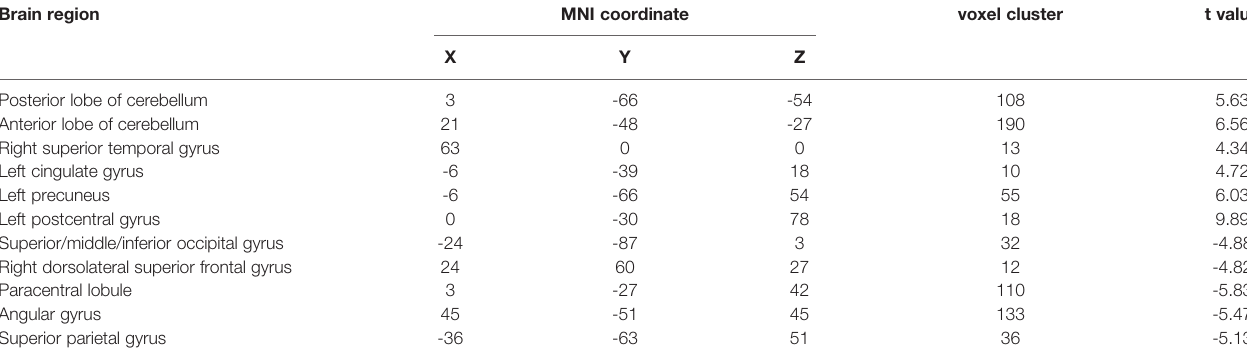
TABLE 2 | The abnormal brain regions and functional connectivity found in the sensorimotor network in ATM and nATM groups. Brain region